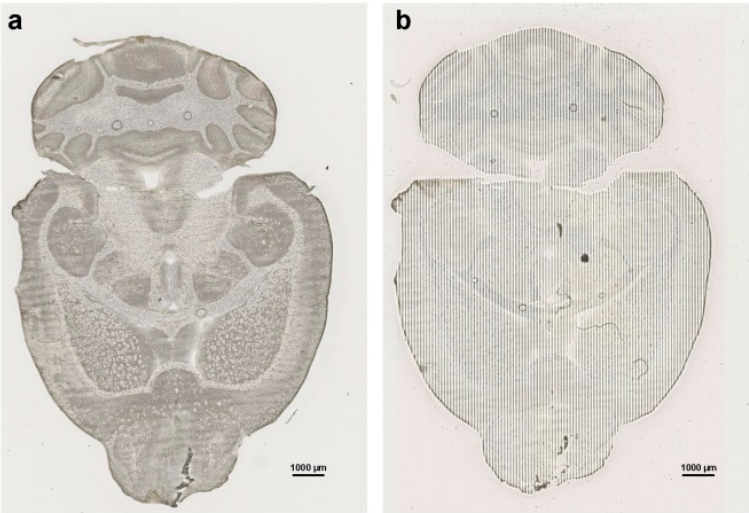
Figure 4. Macroscopic appearance of serial cuts taken from a mouse brain before ( a ) and after ( b ) laser ablation. Please note the typical lines in the ablated sample resulting from the laser bombardment performed as a line-by-line scan with a laser spot size of 80 µ m of the analyzed sample. Size bars represent 1000 µ